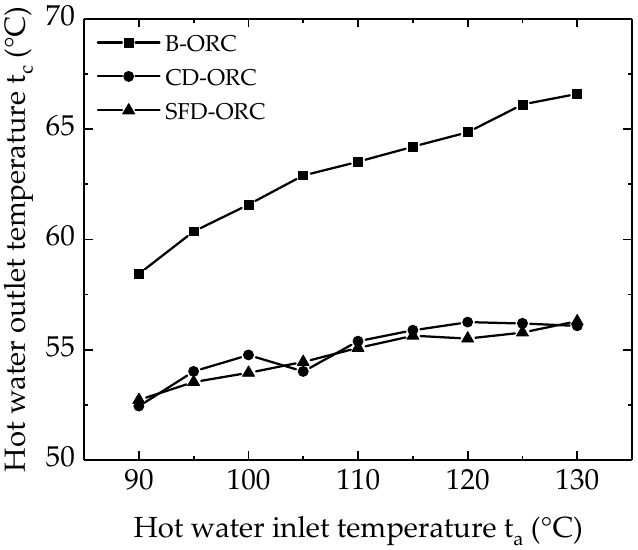
Figure 10. The optimal hot water outlet temperature.